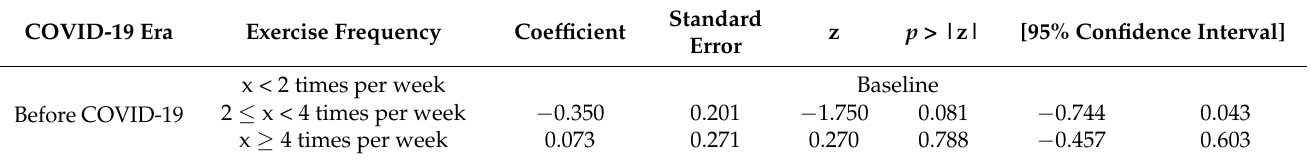
Table 5. The effect of COVID-19 and exercise frequency on mental distress during